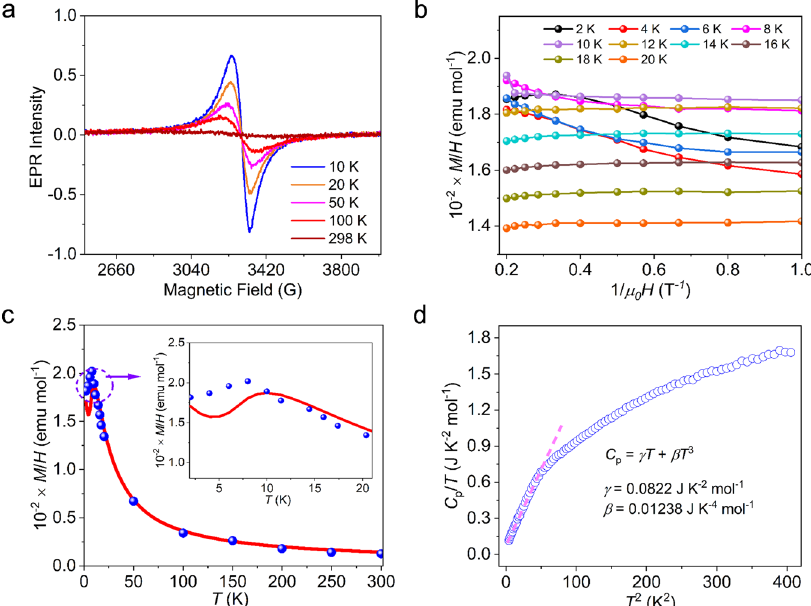
Fig. 6 | Temperature dependence ofvarious physicalpropertiesofCuAg4BHT. a Temperature variable EPR spectrum. b M ( H )| T isotherm measurements per- formed at various temperatures. As argued by Johnston, M ( H )| T = χ ( T ) H + M i ( H )| T , where χ ( T )and M i ( H )| T aretheintrinsicsusceptibilityofCuAg 4 BHTandtheimpurity contribution to M ( H )| T , respectively. c Measured magnetic susceptibility M / H of